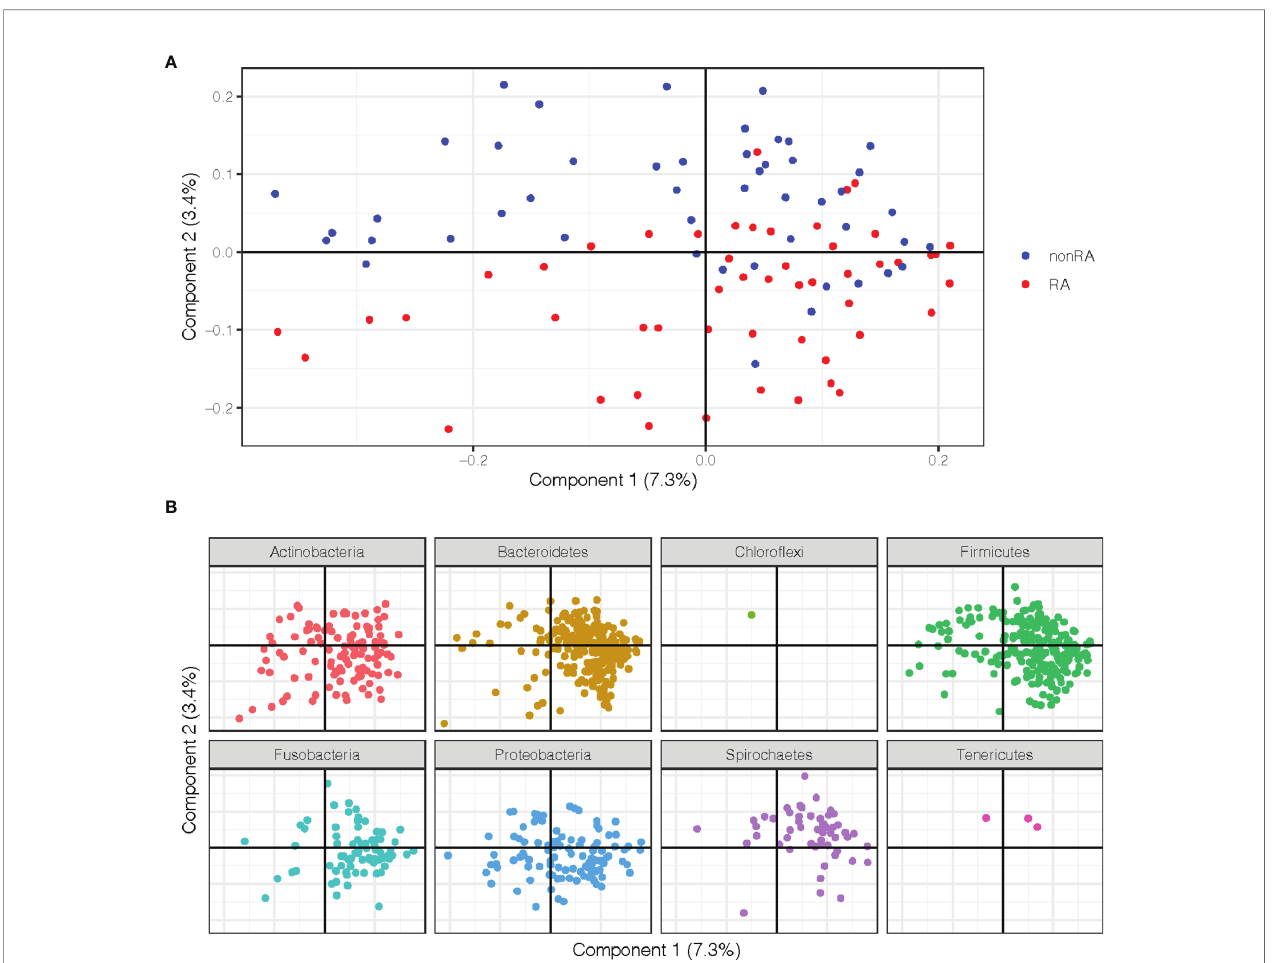
FIGURE 1 | Principal Coordinate Analysis (PCoA) plots on the fi rst two coordinates with UniFrac distances. Variation explained by the coordinates are given within parenthesis. (A) A sample projection plot with the samples color-coded by disease status. Saliva samples from patients with RA and periodontitis are highlighted in red and periodontitis patients without RA are in blue. (B) The contribution of ASVs are visualized in the same PCoA space as the samples and shaded according to their phylum